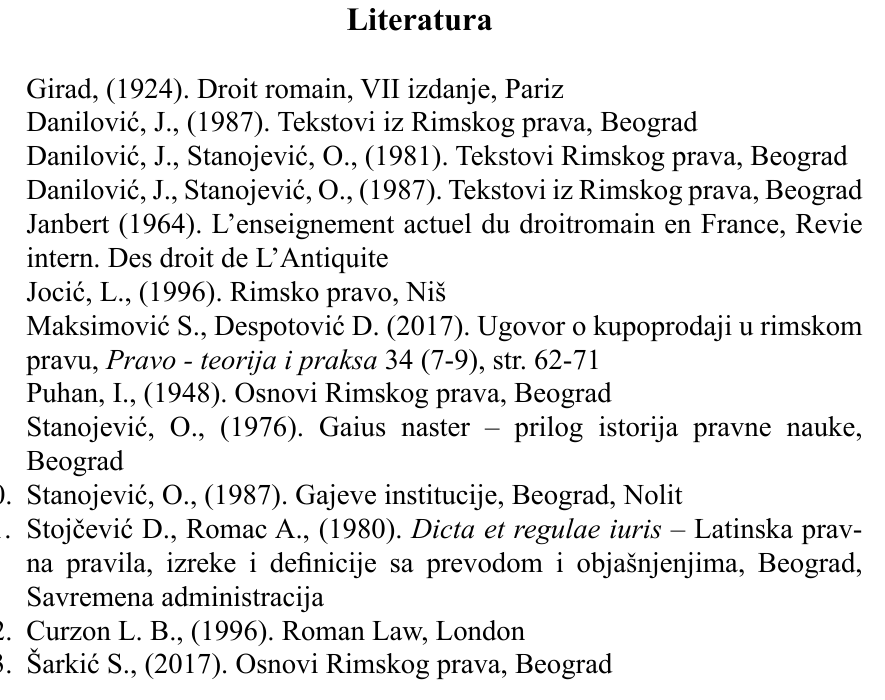
Gaius, suus heres, sui heredes, odgantus